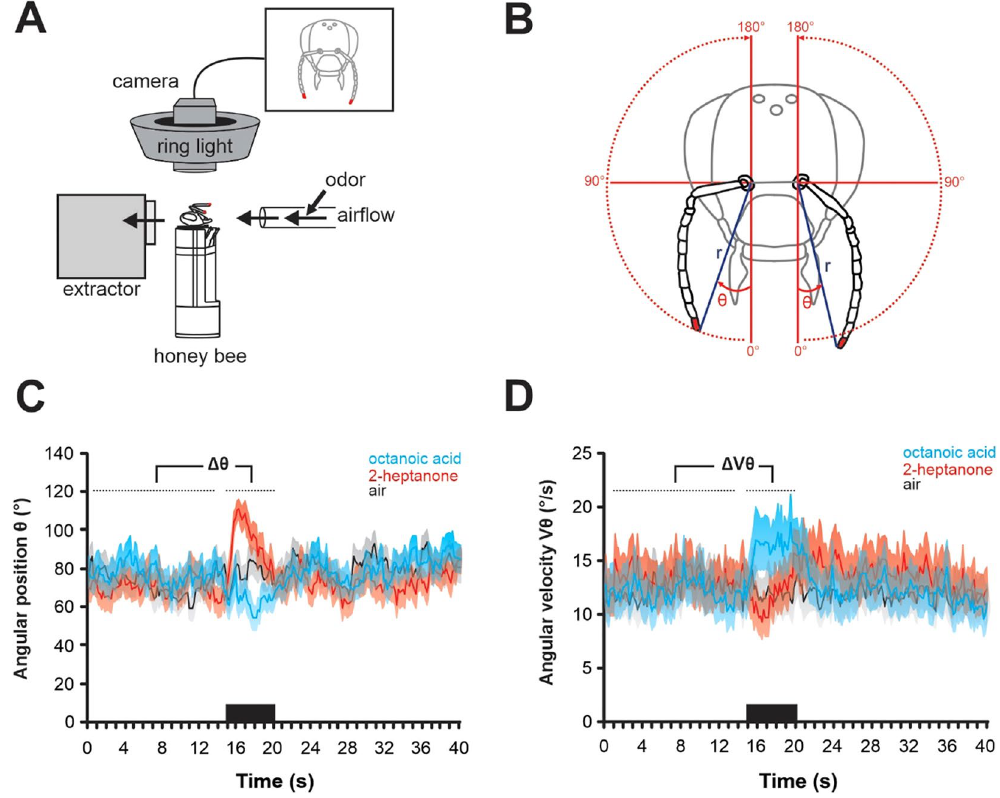
Figure 1. Antennal movements recording. ( A ) Schematic representation of the apparatus for recording bees’ antennal movements. The bee is placed under a camera which detects the colored dots previously applied on bees’ antenna tips. The recording is made in a dark room and the camera is surrounded by a ring light source to control lighting and allow best detection of the color dots. The bee is placed in front of an odor stimulation device. ( B ) Representation of the calculated antennal movement variables: the distance to antenna base (r), the angular position (θ) defined as the angle between the line connecting the antenna tips to their base (r) and an antero-posterior line passing through the corresponding antenna base. The angular velocity (Vθ) is calculated as the angle θ traveled by each antenna during a frame (1/90 s), expressed in degrees per second. ( C,D ) Average recordings of ( C ) antennal angular position (θ) and ( D ) angular velocity (Vθ) in response to the air control (gray line) and to two odorants which induced marked changes: the royal jelly component octanoic acid (blue) and the alarm pheromone component 2-heptanone (red). Curves show average values every 200 ms from the data acquired in the first experiment (N = 24, Fig. 2A,B). Octanoic acid induced a forward motion of the antennae with an acceleration, whereas 2-heptanone induced a backward motion of the antennae with a deceleration. The changes in angular position (Δθ) or angular velocity (ΔVθ) were calculated as the difference between these values during odor presentation (5 s) and before (15